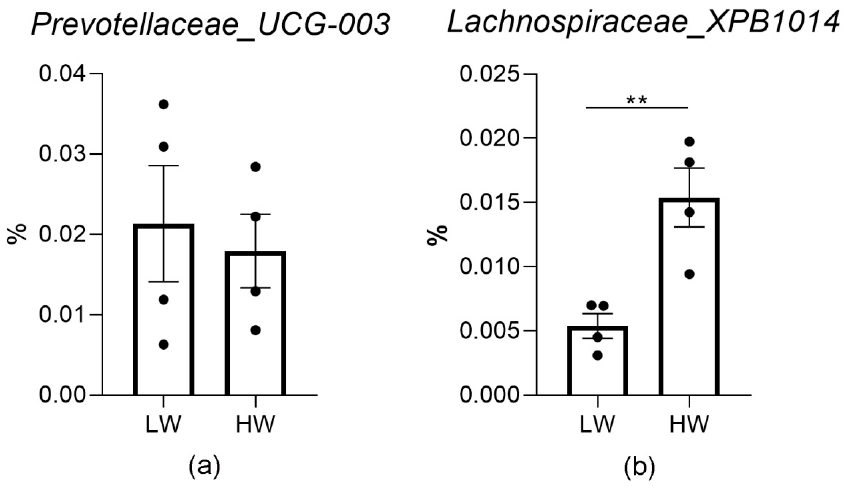
Bacterial composition at the genus level. ( a ) Prevotellaceae_UCG-003 , ( b ) Lachnospiraceae_XPB1014 . **, p < 0.01.